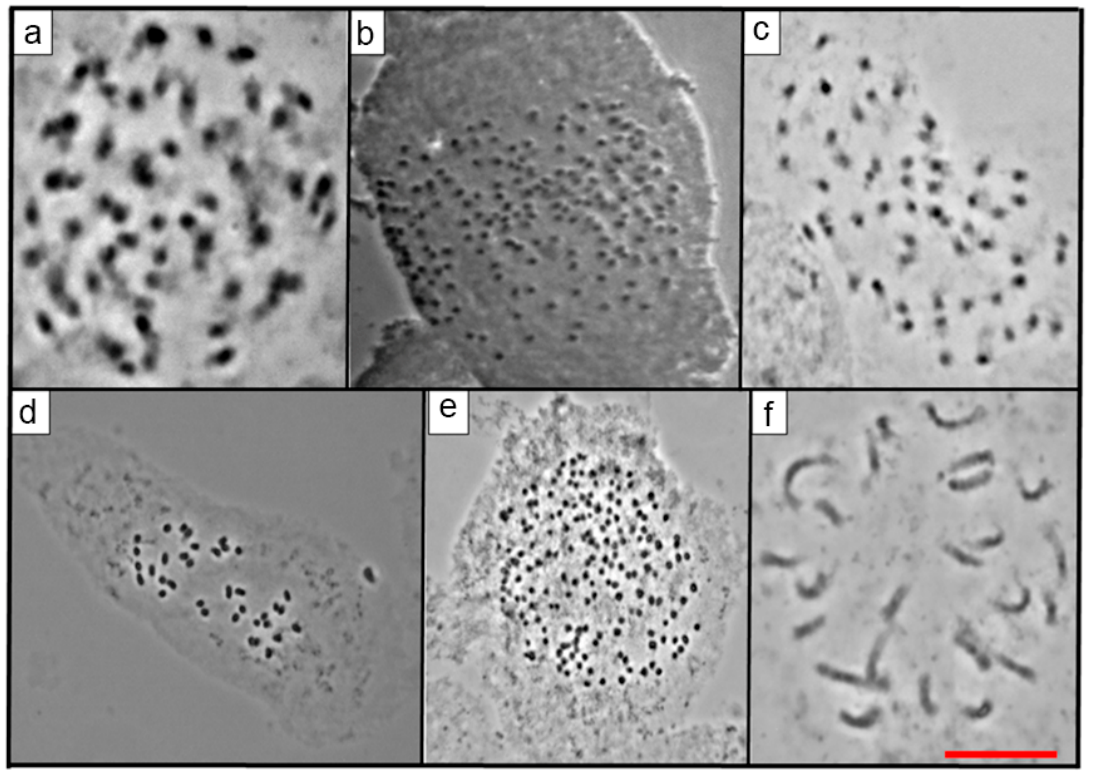
Figure 3. ( a ) E. juarezensis 2 n = 54, ( b ) E. longiflora 2 n = 162, ( c ) E. magnifica 2 n = 54, ( d ) E. multicaulis 2 n = 32, ( e ) E. novogaliciana 2 n = 172, ( f ) E. olivacea 2 n = 28. Scale equals 10 µm.